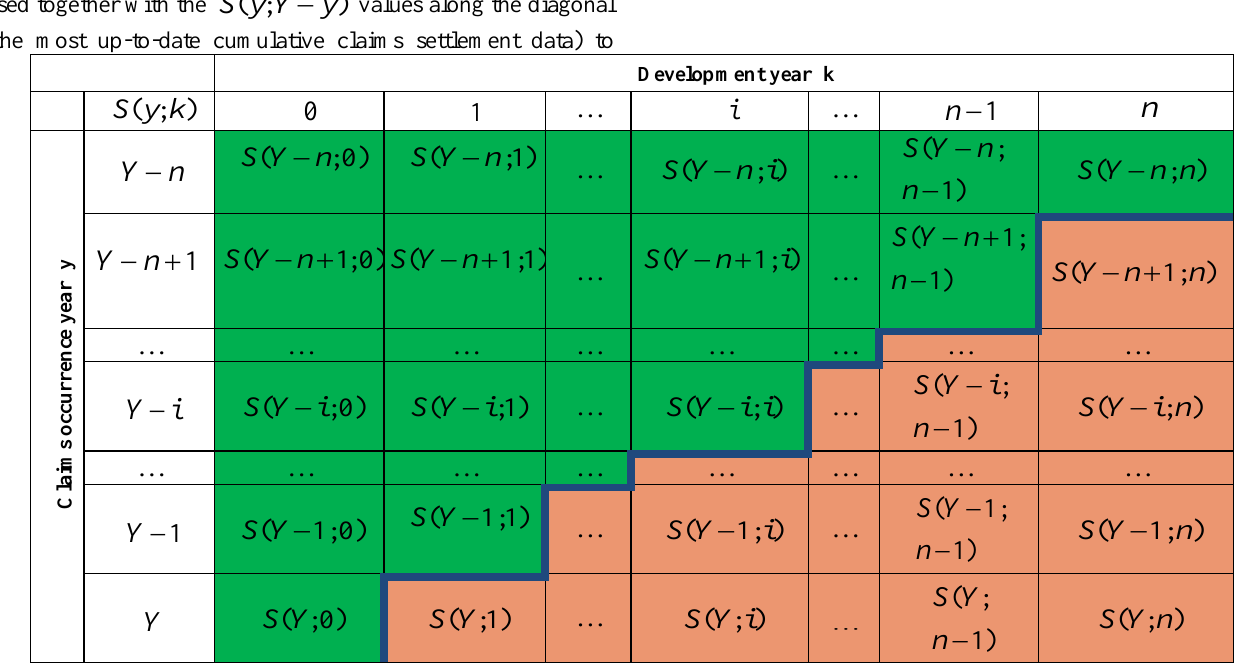
Fig. 2. Cumulative claims loss settlement data represented as a run-off